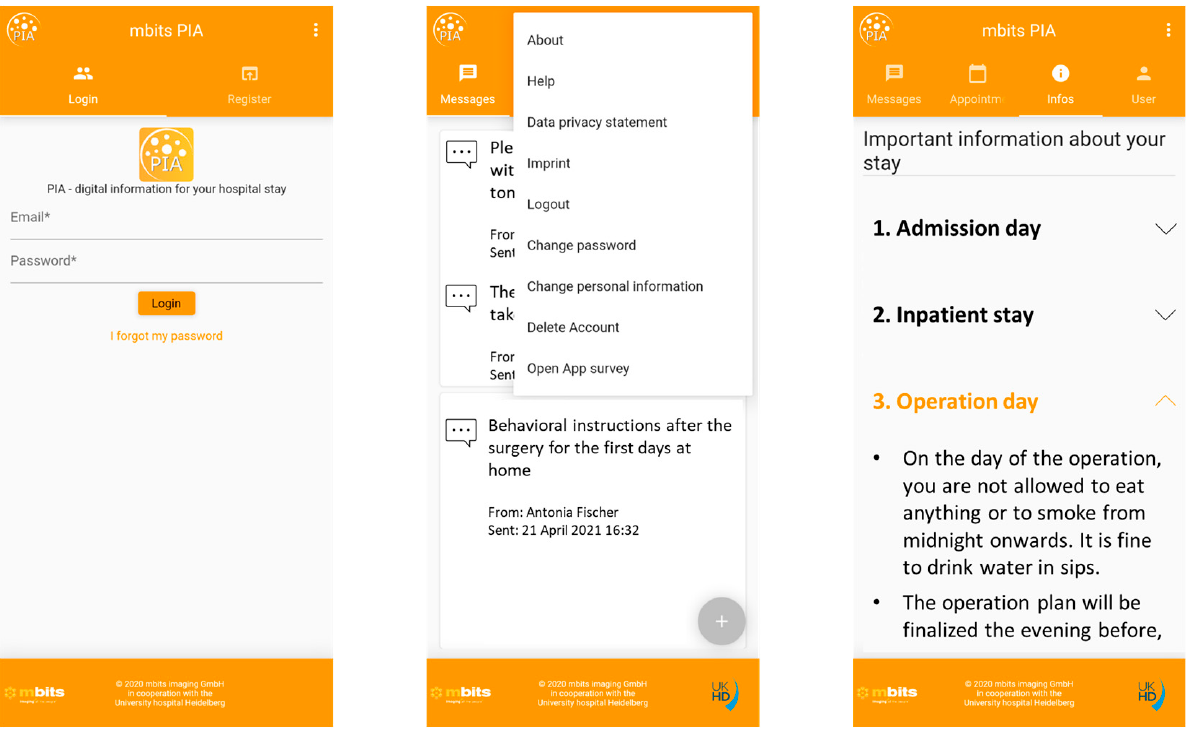
Figure 1. Structure, design, and functionality of the PIA app.